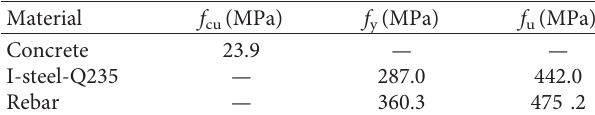
Figure 7: Load-deflection curve of the PPEC beam.